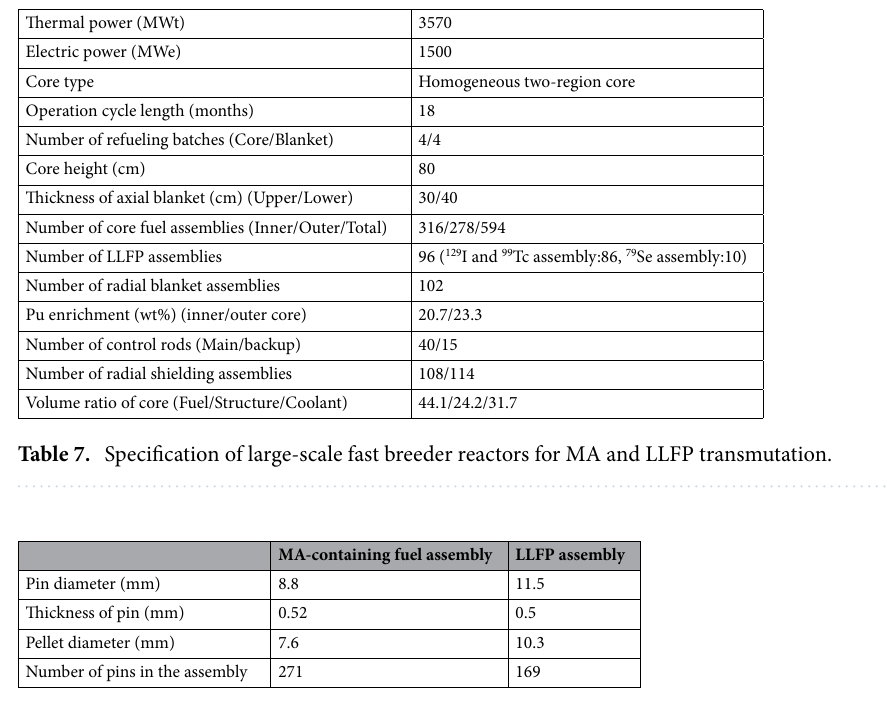
Table 8. Specifications of MA-containing fuel assembly and LLFP